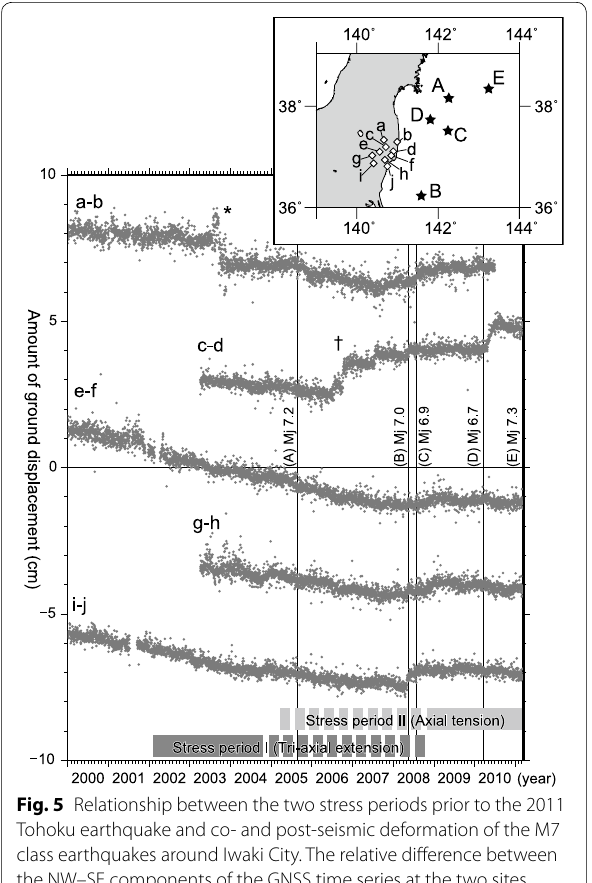
Fig. 5 Relationship between the two stress periods prior to the 2011 Tohoku earthquake and co- and post-seismic deformation of the M7 class earthquakes around Iwaki City. The relative difference between the NW–SE components of the GNSS time series at the two sites among the eight sites (a–h) near Iwaki City is plotted for the period from January 1, 2002, to March 1, 2011. Positive increases correspond to eastward movement. The eight stations for which we analyzed time series of GNSS data are: (a) 950,205; (b) 950,208; (c) 020,944; (d) 940,041; (e) 950,211; (f) 970,800; (g) 020,945; (h) 020,946; (i) 950,212; (j) 950,214. Five M7 class trench-type earthquakes with large post- seismic slips that occurred along the Japan Trench (Suito et al. 2011) are also marked: (A) August 16, 2005, Miyagi-ken Oki earthquake (Mj 7.2); (B) May 8, 2008, Ibaraki-ken Oki earthquake (Mj 7.0); (C) July 19, 2008, Fukushima-ken Oki earthquake (Mj 6.9); (D) March 14, 2010, Fukushima-ken Oki earthquake (Mj 6.7); and (E) March 9, 2011, Sanriku-Oki earthquake (Mj 7.3). Diamonds and stars on the inset map show the stations for the time series used in this study and epicenters of the five M7 class trench-type earthquakes, respectively. The rapid change in a–b (point *) is due to the maintenance of site 940,041. We do not discuss the rapid change in c–d (point †) in this study